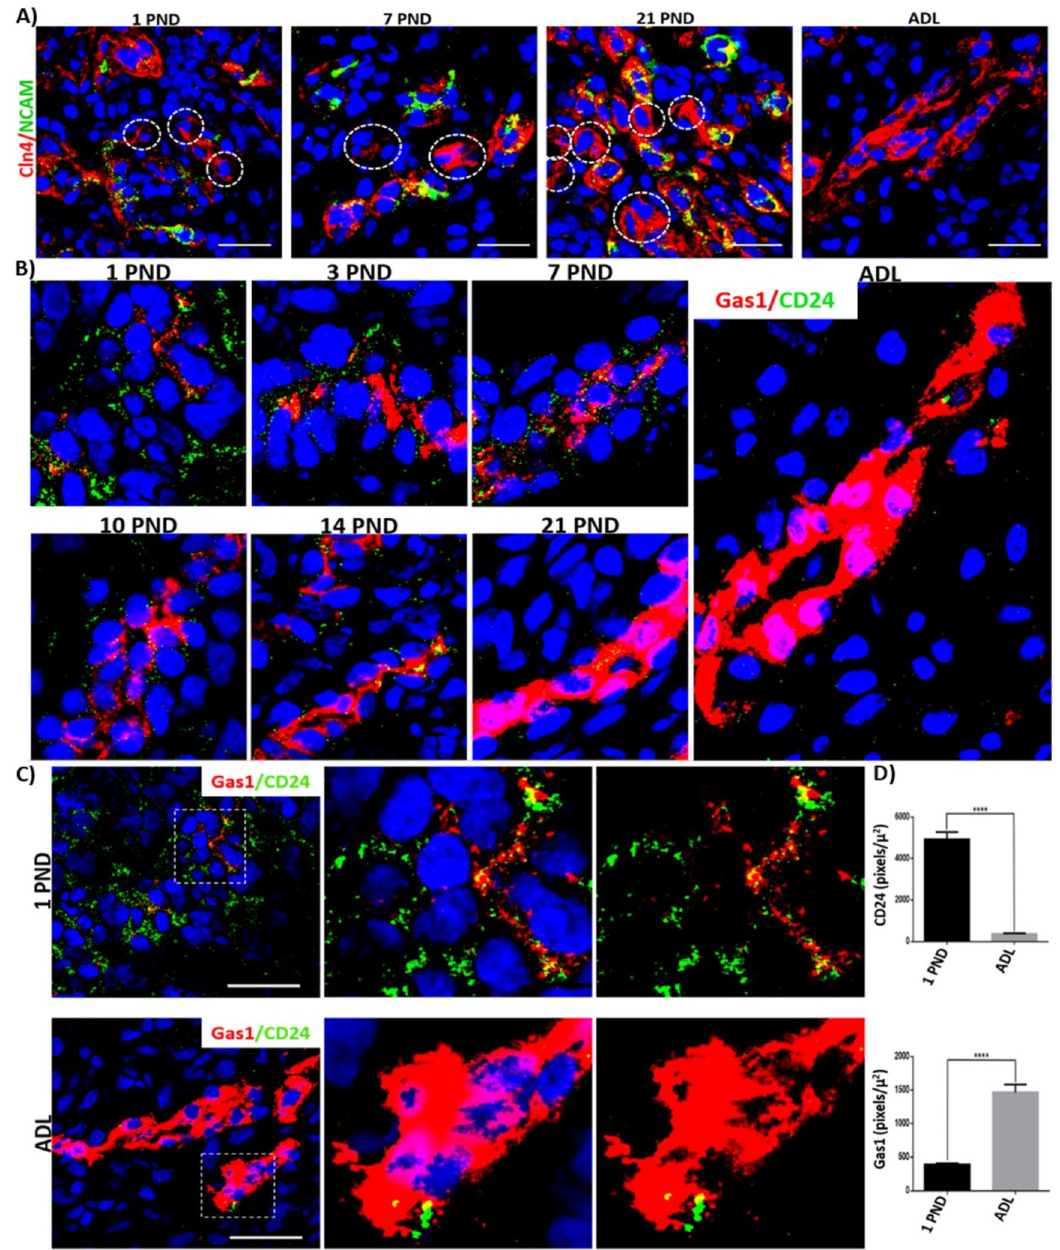
Fig 8. Expression of renal progenitor cell (RPC) markers in the distal nephron during postnatal development and in adulthood of the rat. A) immunofluorescence analysis of the general expression pattern of NCAM in the distal tubules, we found that Cln4 (red) and NCAM (green) are expressed from PND 1, that both proteins colocalize and that NCAM is not expressed in all distal tubules during kidney maturation (dotted circles). B) CD24 (green), is expressed from PND 1 and colocalizes with Gas1 (red) in different areas of the distal tubules during postnatal development, and that the expression of CD24 decreases in the adult nephron. C) Comparison of Gas1/CD24 expression in PND 1 and ADL. D) Semi-quantitative analysis of the comparison of Gas1/CD24 expression in PND 1 and ADL. The white squares represent the magnification of specific areas in the distal tubule. Cln4 (red, A), NCAM (green, A), Gas1 (red, B and C), CD24 (green, B and C), Merge (yellow), and nuclei with DAPI (blue) are shown. Scale bars = 25 μ m. Values are means ± standard deviation (SD). * p < 0.05, **** p < 0.0001. Immunofluorescence experiments were performed in kidney sections. A representative experiment is shown (n =